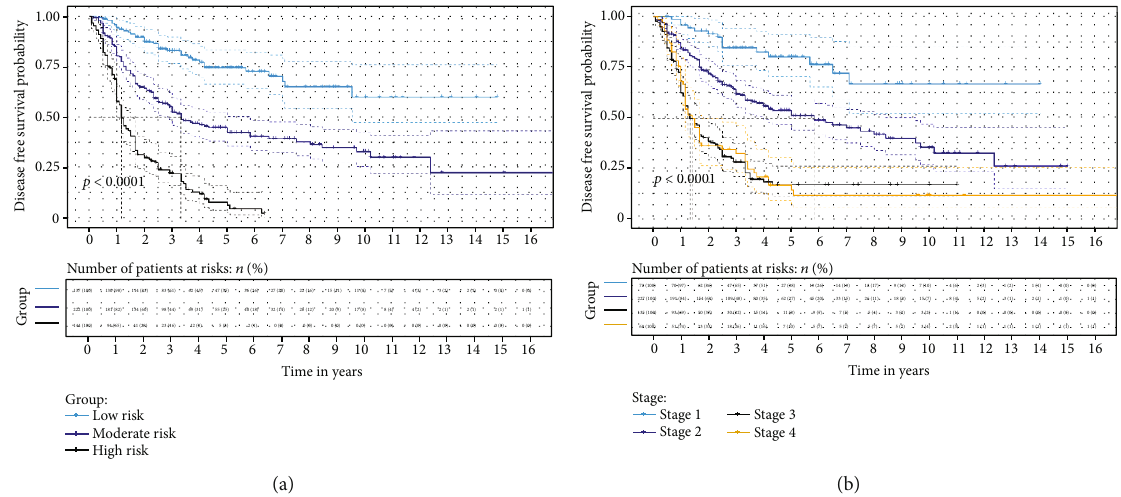
Figure 4: Kaplan-Meier survival curves of the primary cohort categorized by di ff erent staging systems for disease free survival ((a) established model; (b) American Joint Committee on cancer (AJCC) seventh